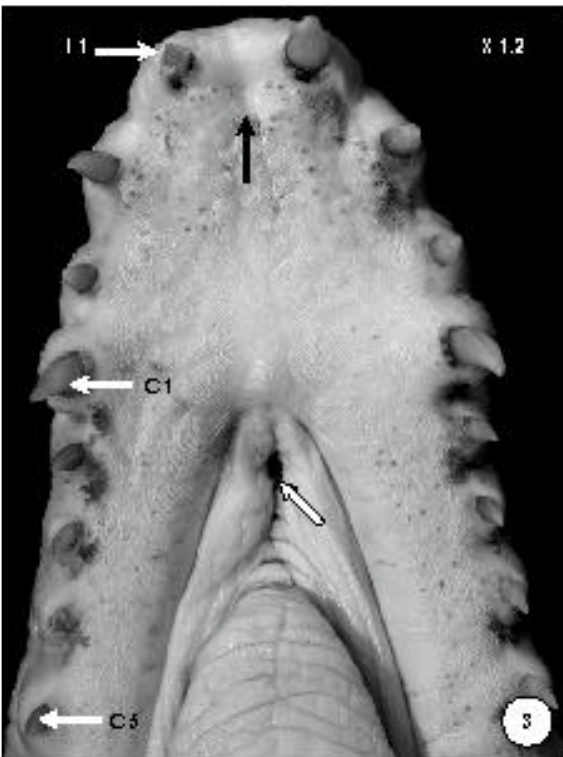
FIG. 1 Macrophotograph of the mandible with the tongue in situ showing the dental arrangement of the incisor (I 1–3), canine (C 1–5) and molar (M 1–7) teeth, demarcated by the stippled lines. The sampling sites for histology of the gingivae (D and E) are also indicated. The rostral dentary shelf is indicated in the region above the symphysis of the dentary bones. The black arrowhead indicates the position of the shallow depression which houses the small, rigid, conically formed process, situated at the base of the I 1 teeth, seen in Fig. 2. The glottis (GT) and laryngeal mound (LM) are shown in situ on the floor of the pharyngeal cavity and the ventral fold (VF) of the gular valve is seen separating the ventral aspects of the oral and pharyngeal cavities. Formalin fixed specimen. X 0.75 FIG. 2 Macrophotograph of the maxilla and palate showing the dental arrangement of the incisor (I 1–5), canine (C 1–5) and molar (M 1–8) teeth, demarcated by the stippled lines. The smooth area of the palate, demarcated by the black arrows, lies above the left and right posterior palatine foraminae. The small, rigid, conical process, situated at the base of the I 1 teeth, is indi- cated by the arrowhead. Also note the smooth zone of mucosa forming the gingiva adjacent to the teeth (asterisks) which stretches from approximately I 5 to M 8 on both sides of the maxilla. The common opening of the internal nares (IN) is seen on the roof of the pharyngeal cavity as well as the dorsal fold (DF) of the gular valve which separates the dorsal aspects of the oral and pharyngeal cavities. Samples of the mucosa of the palate and gingiva were removed from regions A, B and C as indicated on the photograph. Formalin fixed specimen. X 0.75